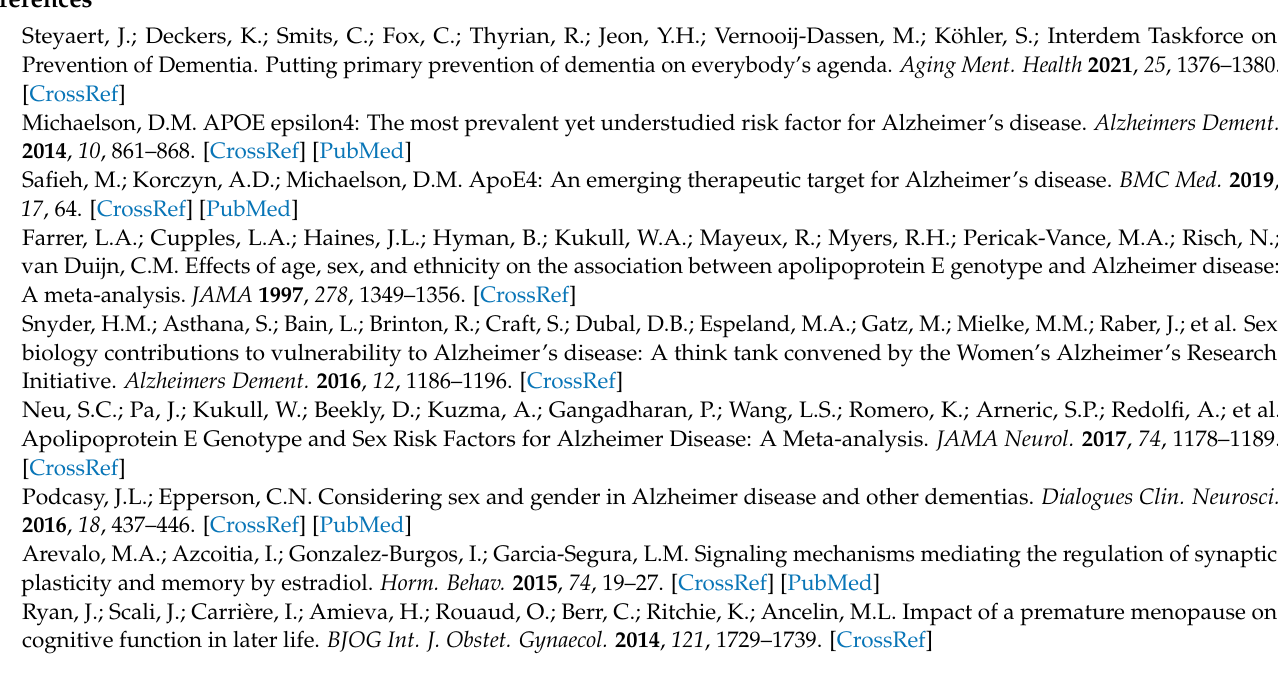
analysis, Table S3: Full correlation analysis results, Figure S1: Pearson’s correlation indicates that NOR behavioural test was not influenced by locomotor